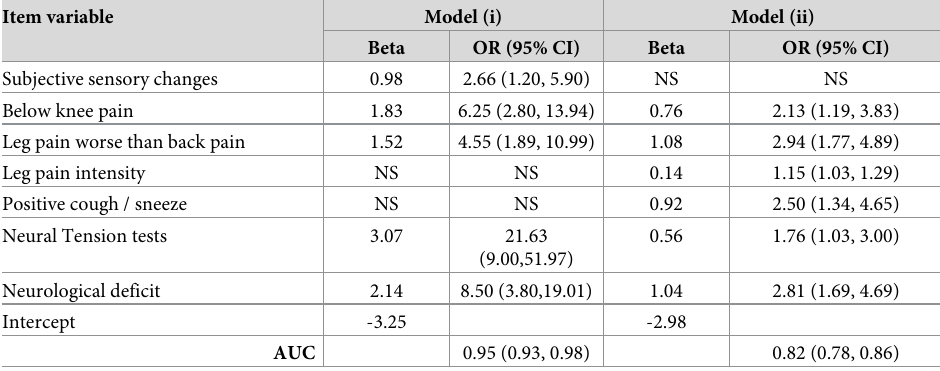
Table 3. Multivariable associations between the clinical assessment items and sciatica for model (i) and model